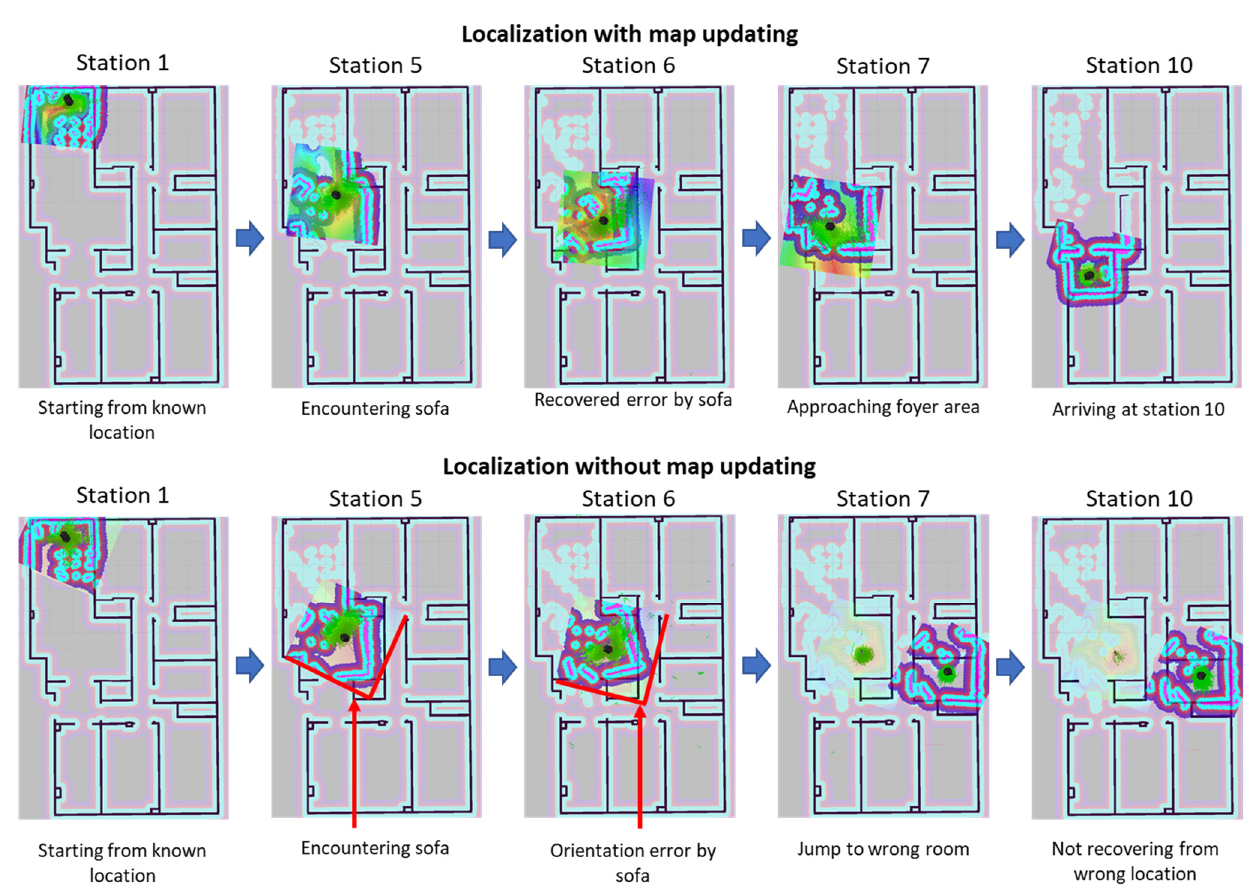
Figure 12. Traditional localization scenario: navigation without map updating ( top ) and traditional navigation with map updating ( bottom